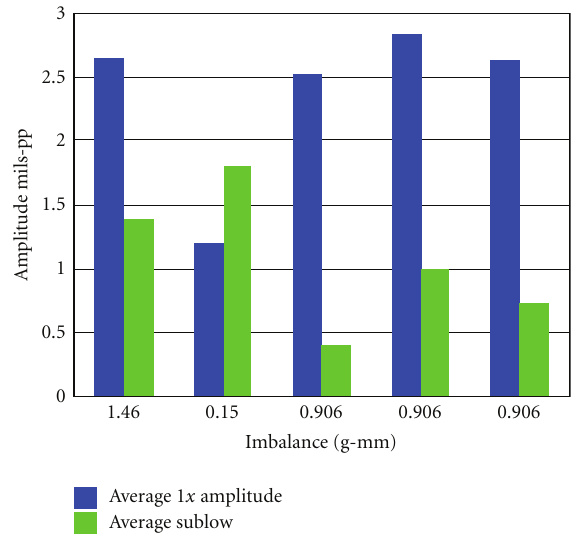
Figure 13: Average levels for runs 11–15, sync , and 1st mode